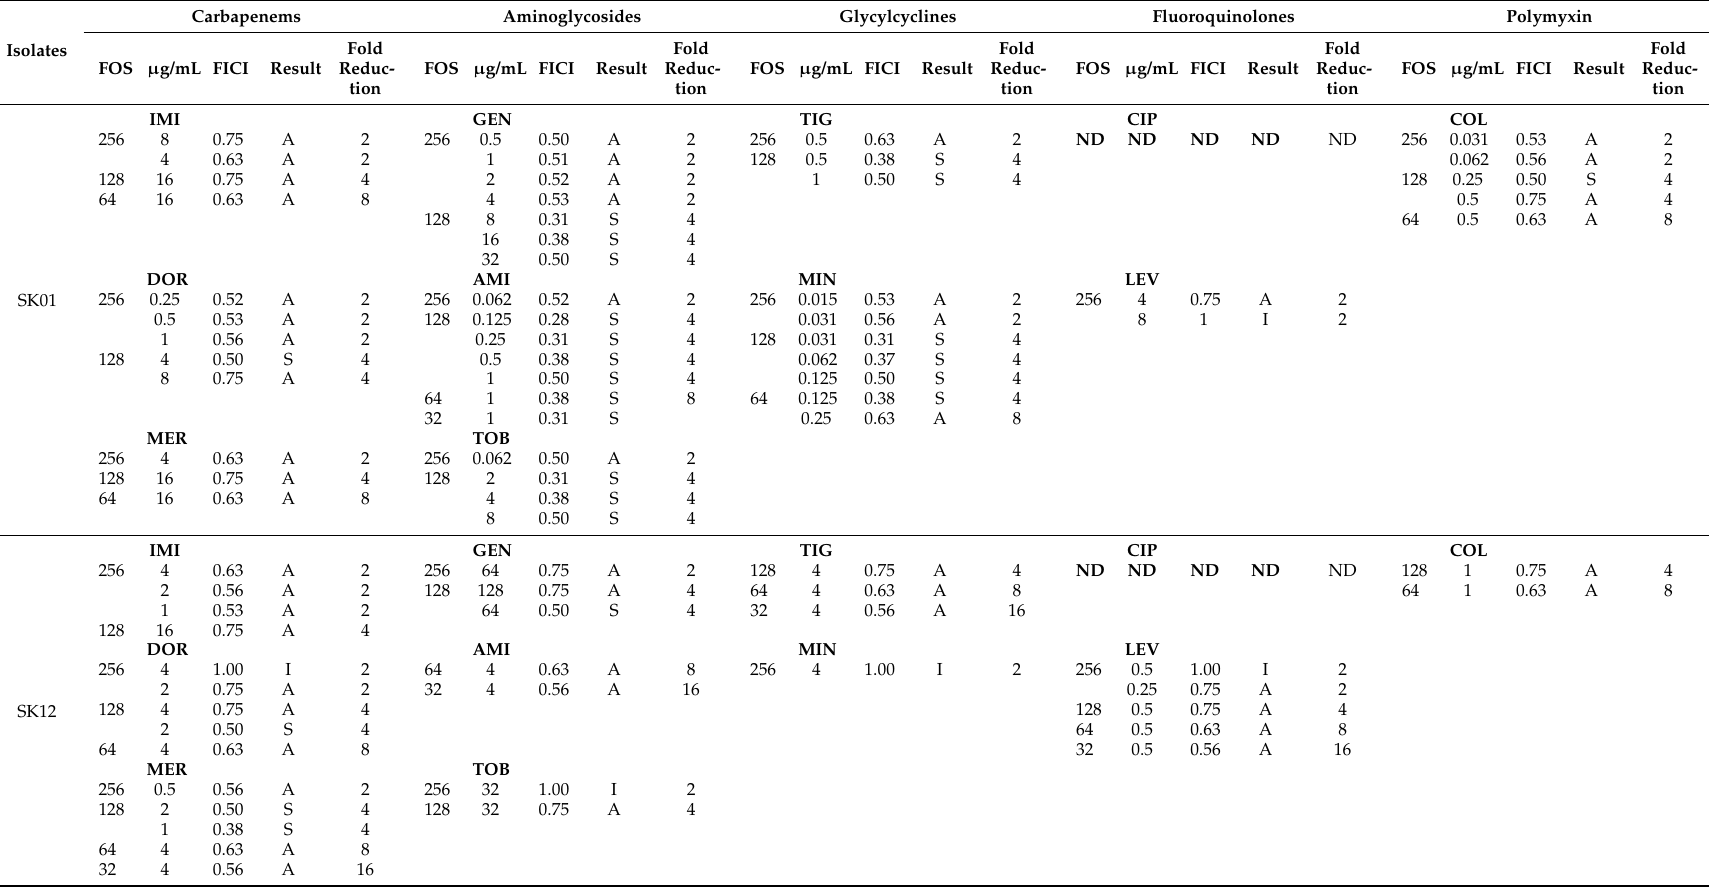
Table 3. Combinatory antibacterial activity of subinhibitory concentrations of fosfomycin with conventional antibiotics on carbapenem and fosfomycin-resistant Acinetobacter